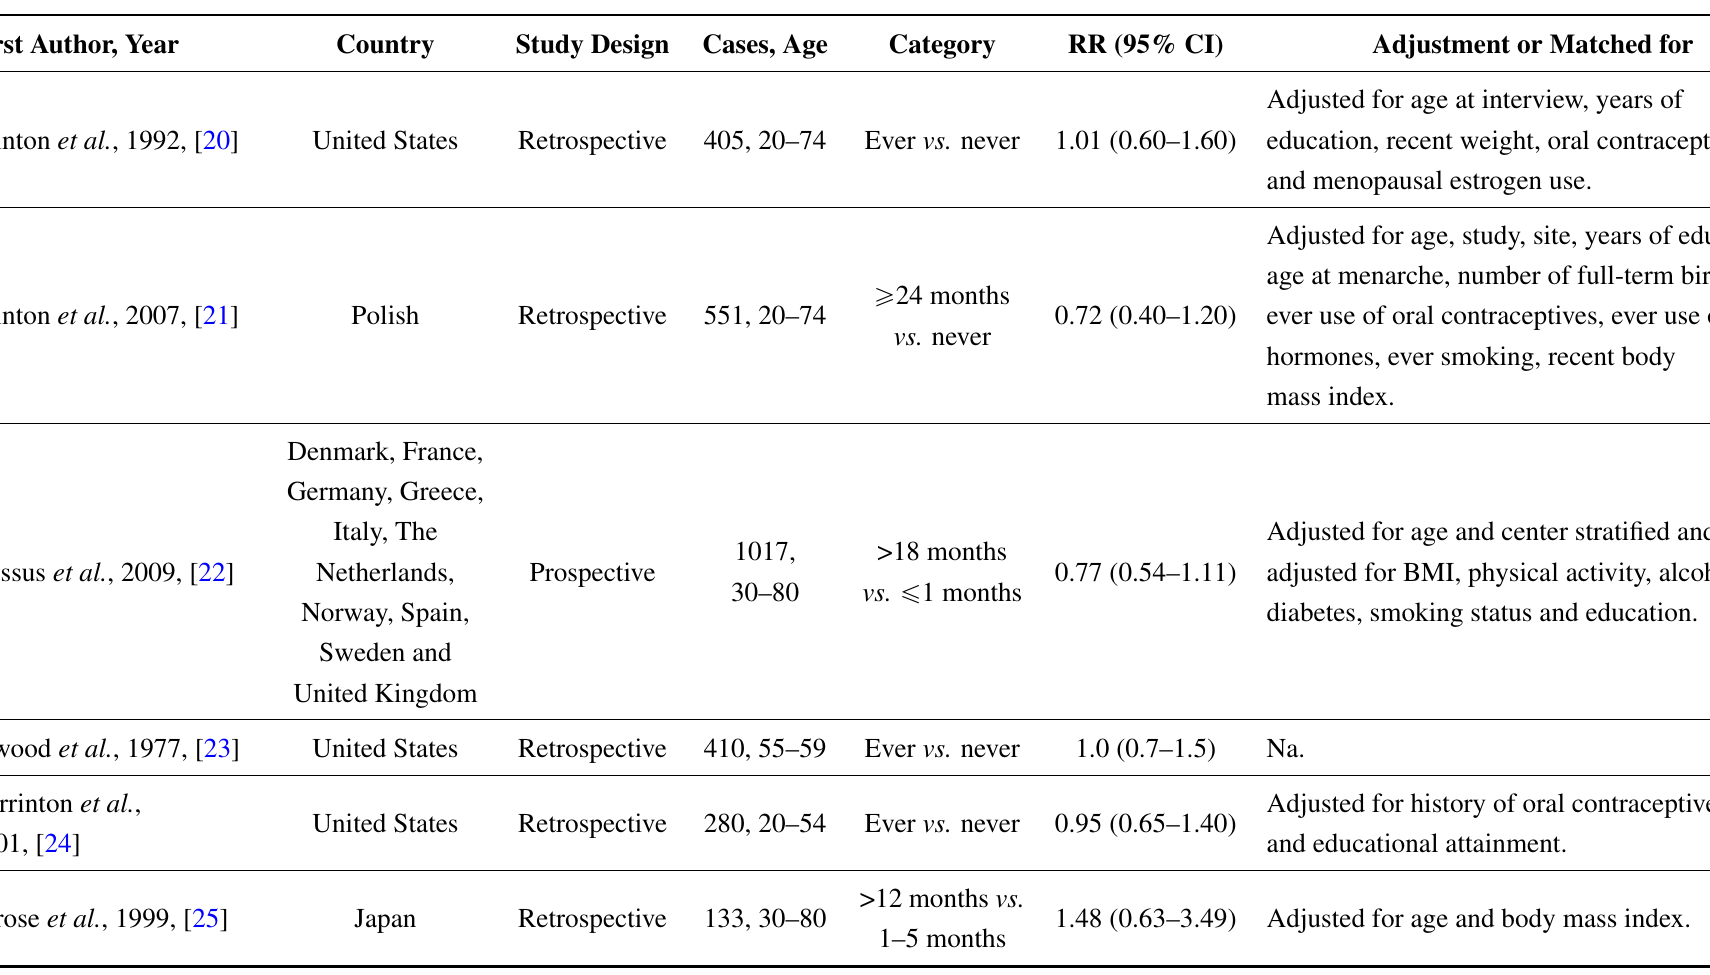
Table 1. Characteristics of studies on breastfeeding and endometrial cancer